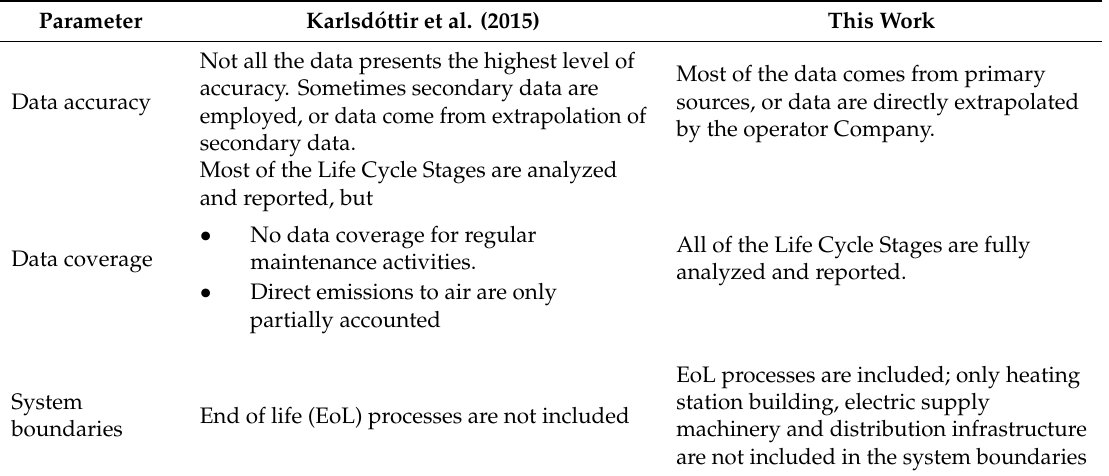
Table 3. Main di ff erences between the currently available life cycle inventories for flash technology.